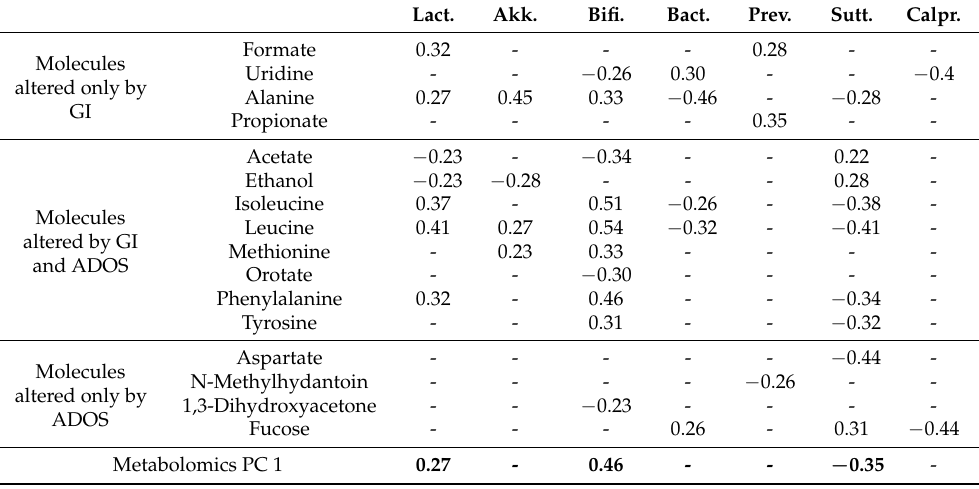
Table 3. Key correlations in all the subjects studied among microbiology, calprotectin, and metabolomics